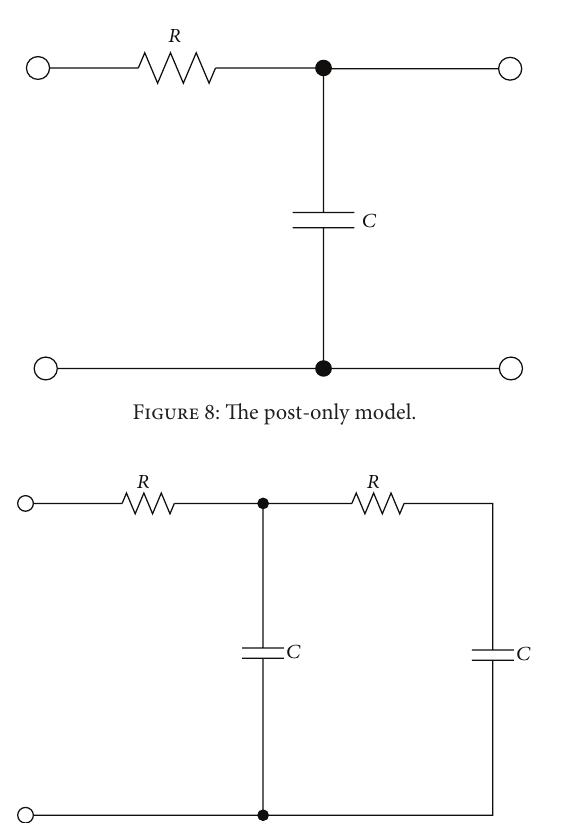
Figure 9: Equivalent circuit for a capacitor with one set of posts and teeth.